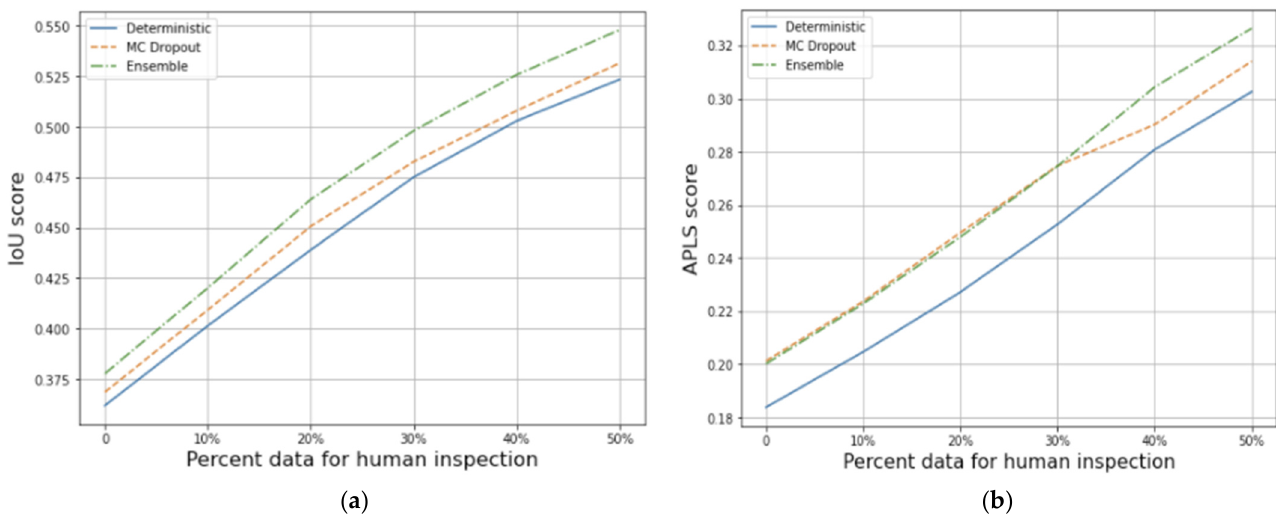
Figure 8. IoU ( a ) and APLS scores ( b ) over data retention rates for ID data. DEs provide the best performance overall, and MCD outperformed the deterministic model. Table 2. Summary of model performance over all levels of data retention for ID data. Calculated from results plotted in Figure